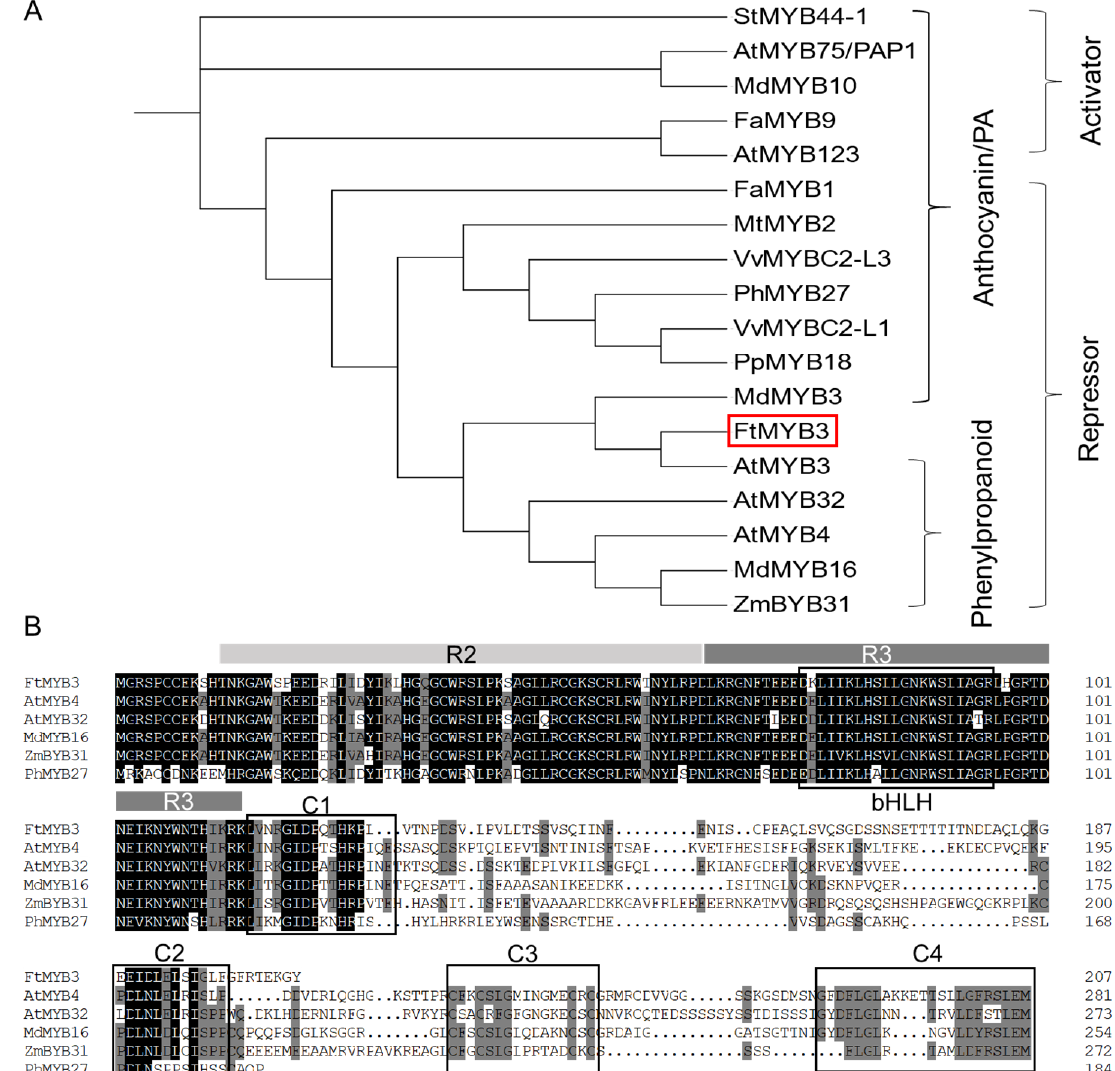
Figure 1. Molecular identification of FtMYB3. ( A ) Phylogenetic tree derived from amino acid sequences of R2R3-MYB TFs in Tartary buckwheat and other species. GenBank accession numbers are as follows: StMYB44-1 (QCH00894.1), AtMYB75 (Q9FE25.1), MdMYB10 (ACQ45201.1), FaMYB9 (JQ989281.1), AtMYB123 (Q9FJA2.1), FaMYB1 (AF401220), MtMYB2 (XP_003616388.1), VvMYBC2-L3 (KM046932), PhMYB27 (AHX24372.1), VvMYBC2-L1 (ABW34393), PpMYB8 (ACA33844.1), MdMYB3 (AEX08668.1), FtMYB3 (AEC32978.1), AtMYB3 (BAA21618.1), AtMYB32 (EFH43356.1), AtMYB4 (BAA21619), MdMYB16 (ADL36756.1), ZmMYB31 (NP_001105949). FtMYB3 is highlighted with a red box. ( B ) Multiple sequence alignments of MYB3. Conserved residues are highlighted in black and partial conservation is shown in grey. The R2 and R3 domains are indicated in greyish white and grey boxes, respectively. Conserved motifs in the C terminus are boxed and numbered as C1~C4. Identical and similar amino acid residues are marked in black and grey, respectively.